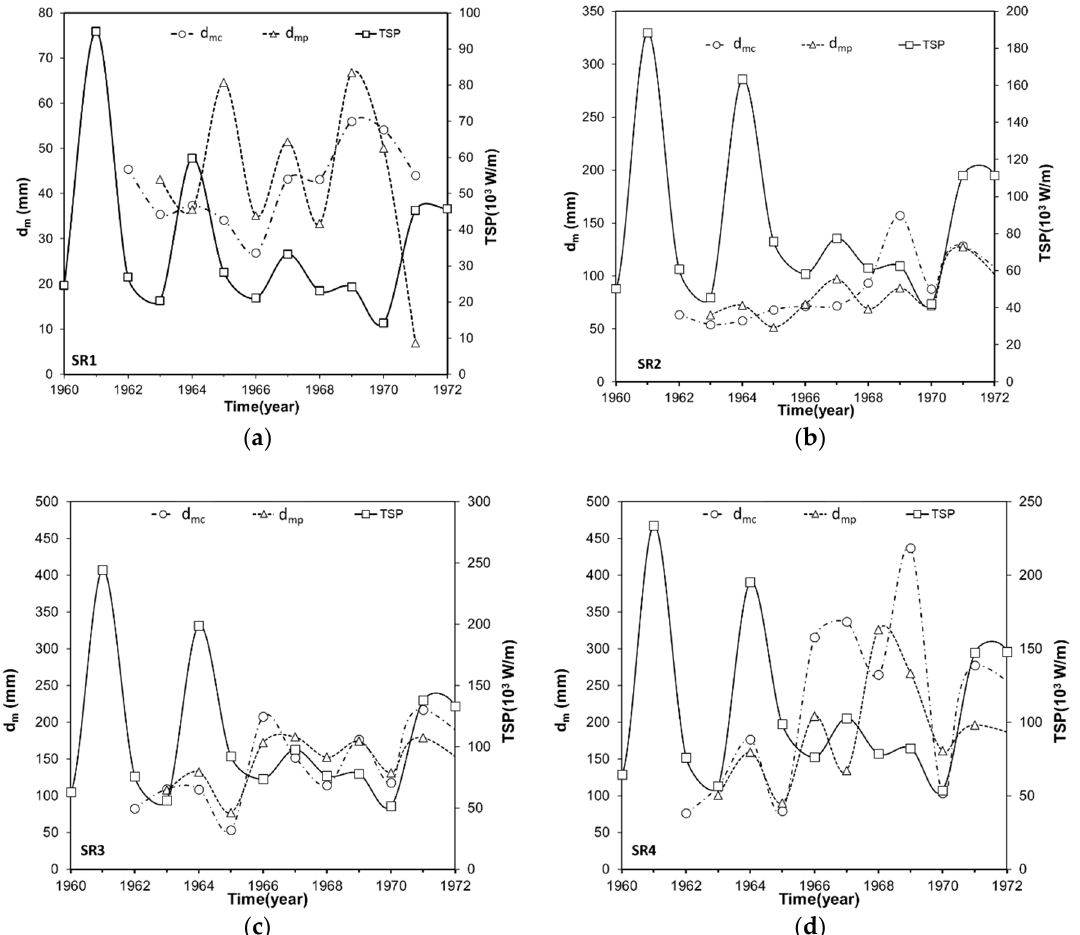
Figure 13. Temporal variation in total stream power and sediment mean diameter ( d m ) of lower Tedori River (LTR).